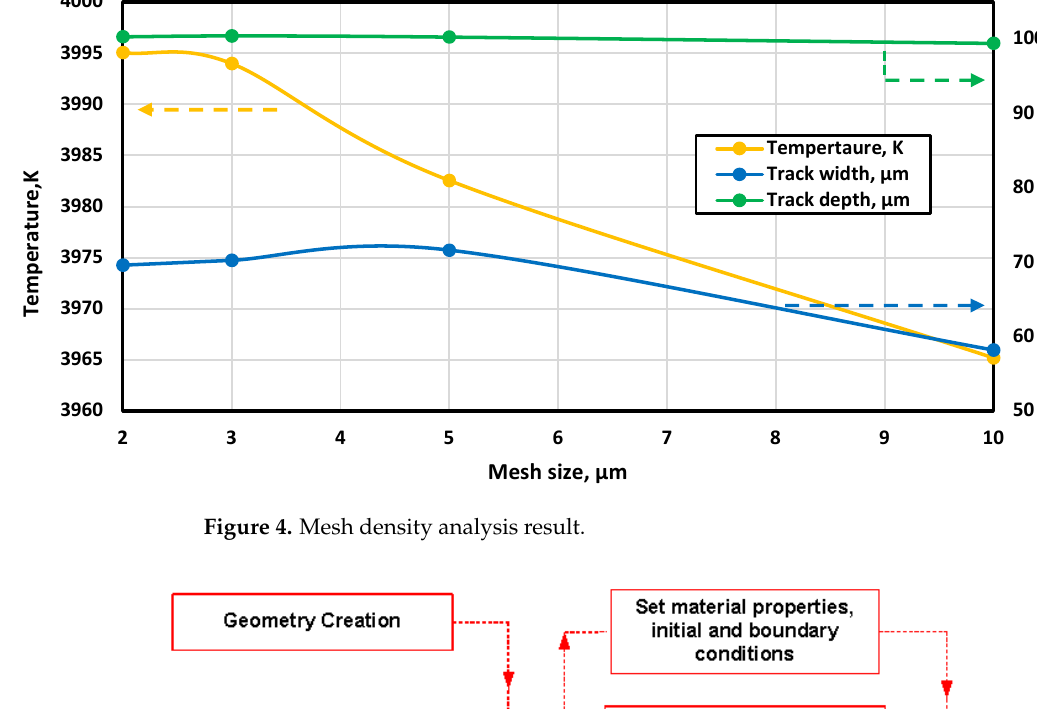
Figure 4. Mesh density analysis result.